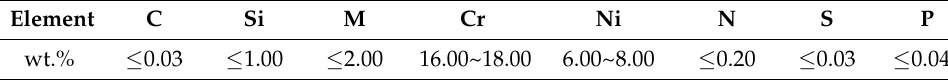
Table 1. Chemical composition of SUS301L–ST.